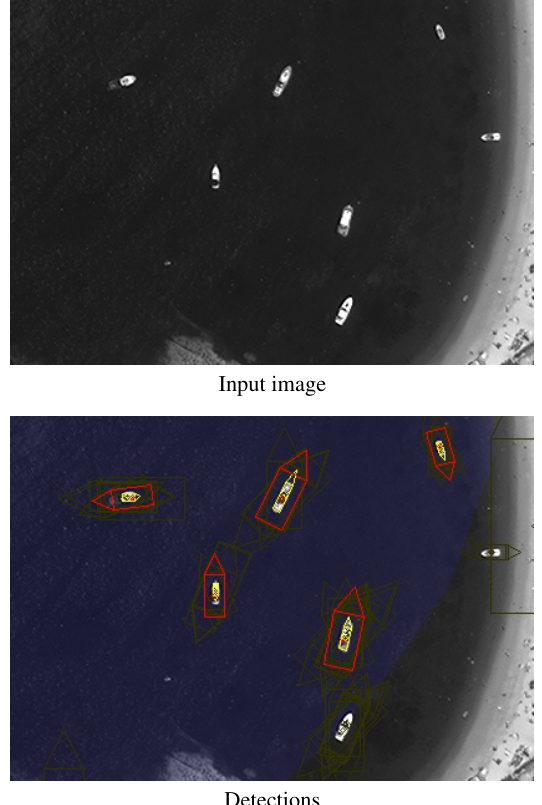
Figure 6: Results for WV2 image near Sidney, Australia Direct comparison with other methods is difficult since the input data is different with different ground sampling distances and the targeted vessels have different sizes.